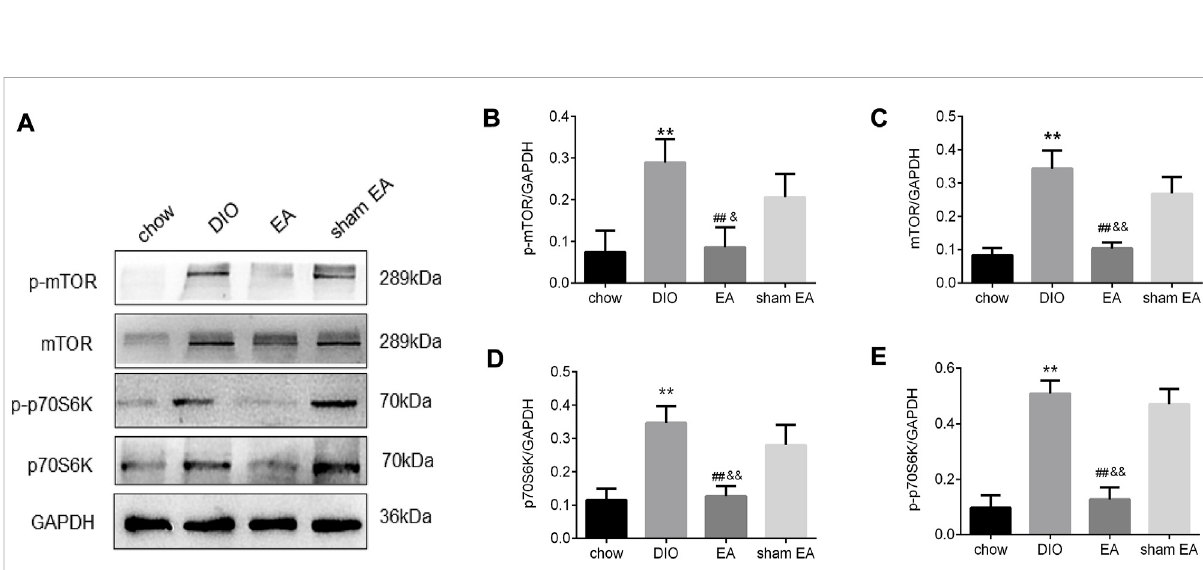
FIGURE 5 EA treatment suppresses the protein expression of mTOR and p70S6K in the hypothalamus. (A) Immunoblot image showing mTOR, p-mTOR, p70S6K, andp-p70S6K; (B) relativeproteinexpressions ofp-mTOR, (C) mTOR, (D) p70S6K, and (E) p-p70S6Kdetected byWestern Blot. Alldata are expressed as Mean ± SD ( n = 5 rats per group), ** p < 0.01 vs. chow; ## p < 0.01 vs. DIO; && p < 0.01 vs. sham EA. EA, electroacupuncture; DIO, diet- induced obesity. EA treatment decreased the methylation rate of the TSC1 gene promoter in the